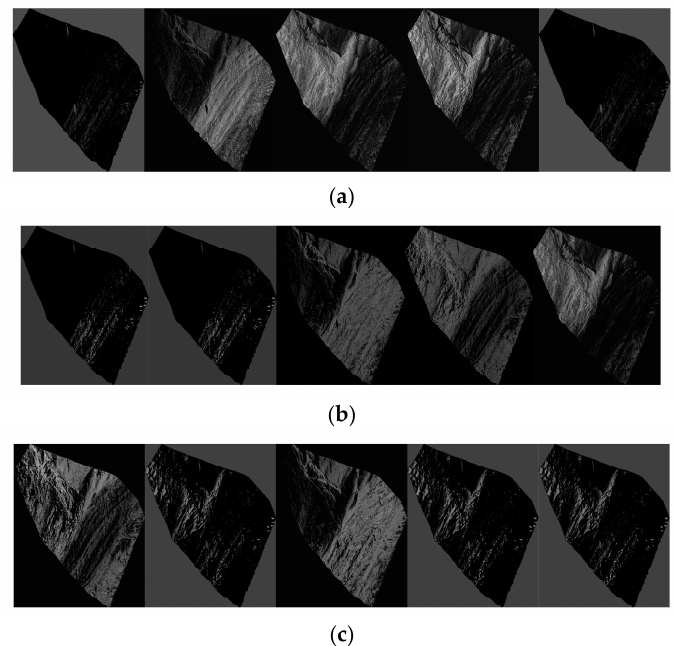
Figure 8. Feature extraction results for each layer in S2. ( a – c ) show results from the first to the third layer.